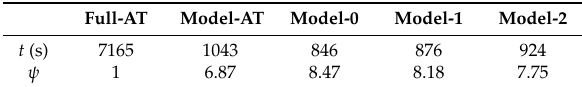
Table 3. The runtime t (s) and the coarse-graining efficiency ψ for different models. ψ is calculated with respect to the runtime of the fully-resolved atomistic model (Full-AT). Twenty-four cores are used in each run of dislocation/ISF interactions in Ni subject to an applied shear strain of